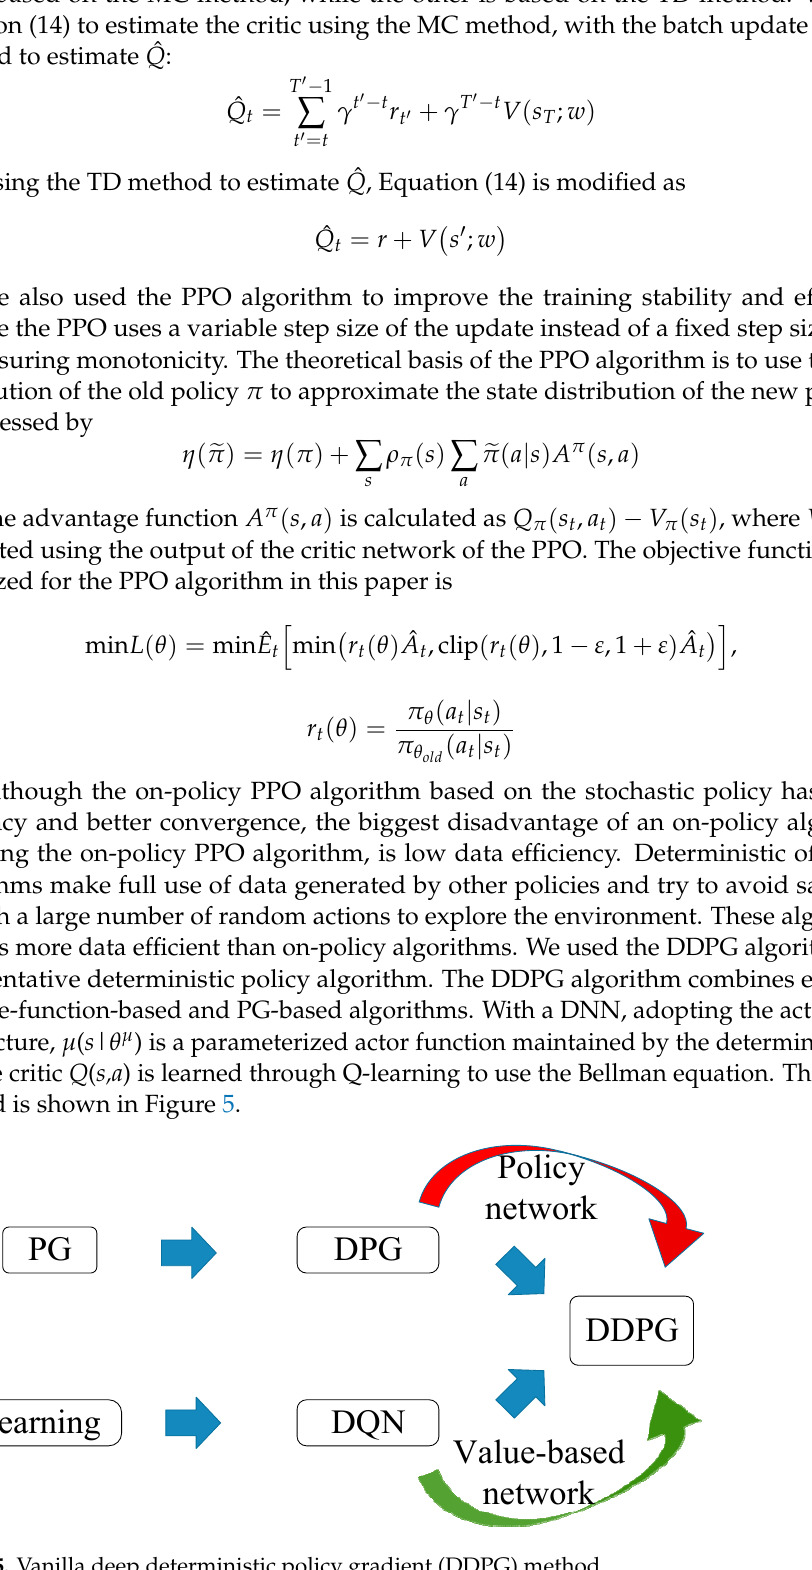
Figure 5. Vanilla deep deterministic policy gradient (DDPG) method.